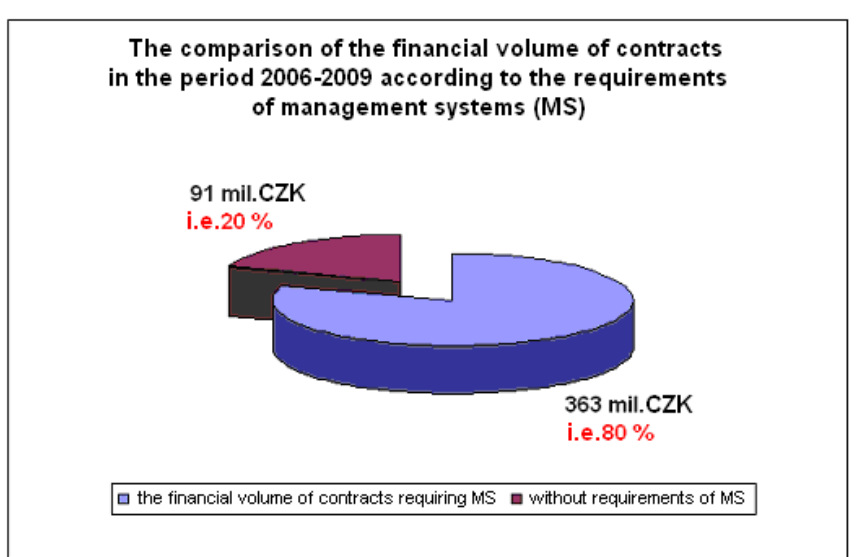
Figure 1- Chart illustrate the financial volume of orders (contracts) in the